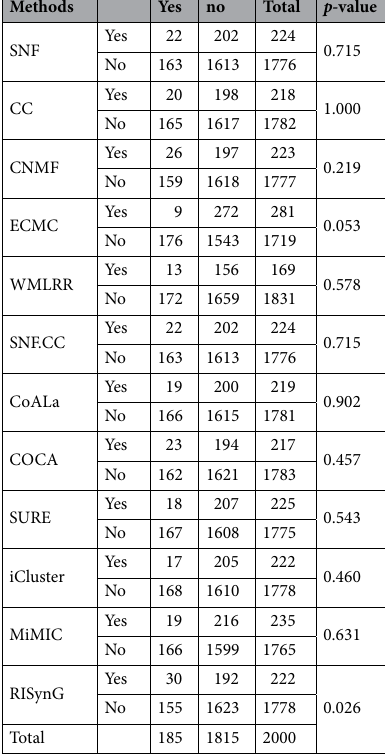
Table 10. Overlap with experimentally validated